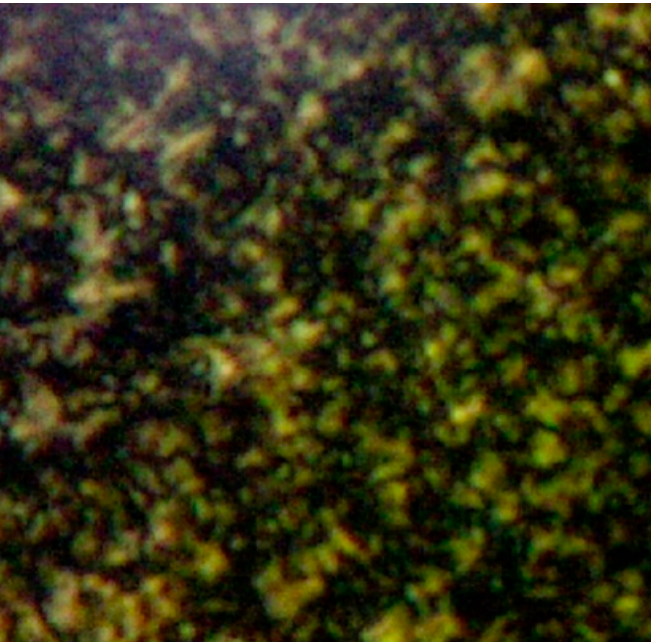
Figure 1. Picture of birefringent mesophase with mosaic-like texture, observed via polarized optical microscopy of 4 in a heating cycle at 103 °C.